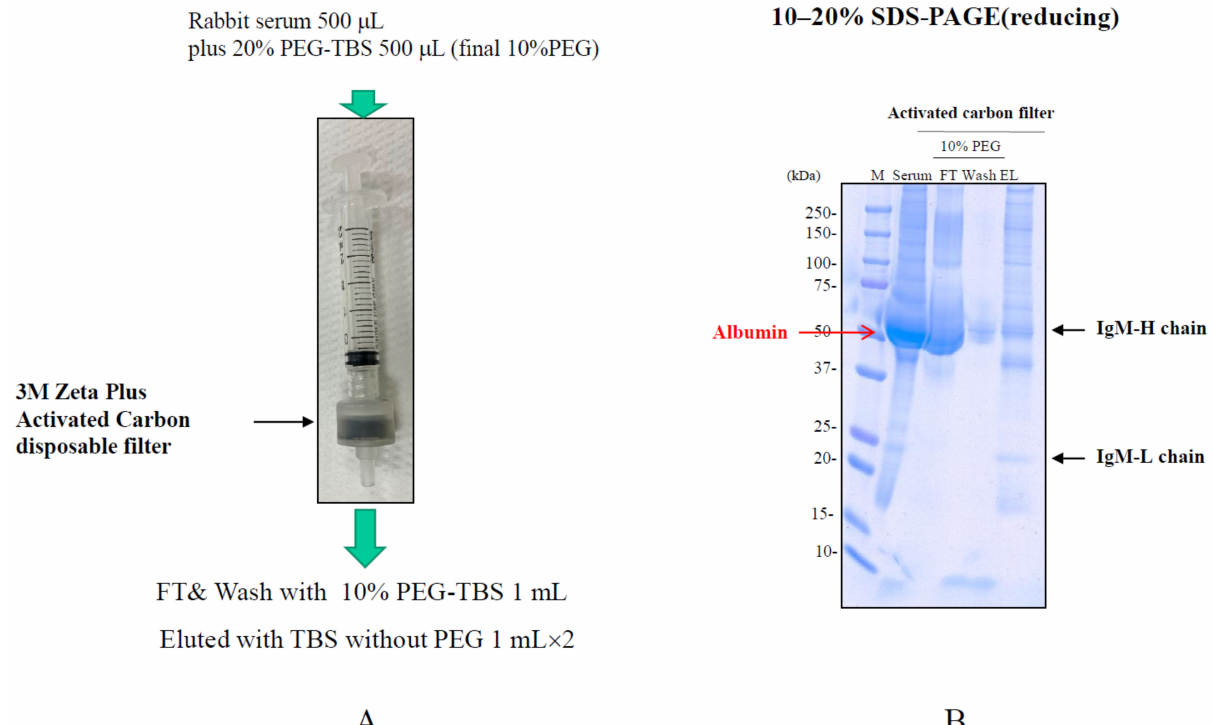
Figure 13. Purification of rabbit serum IgM using activated carbon filter and PEG 6000. Rabbit serum containing IgM was made 10% PEG and injected into the carbon filter. The bound proteins were eluted with TBS lacking the PEG. ( A ) Illustration of the activated carbon filter and scheme of purification methods. ( B ) SDS-PAGE shows load, FT, wash with the TBS containing 10% PEG and eluted fractions by TBS without